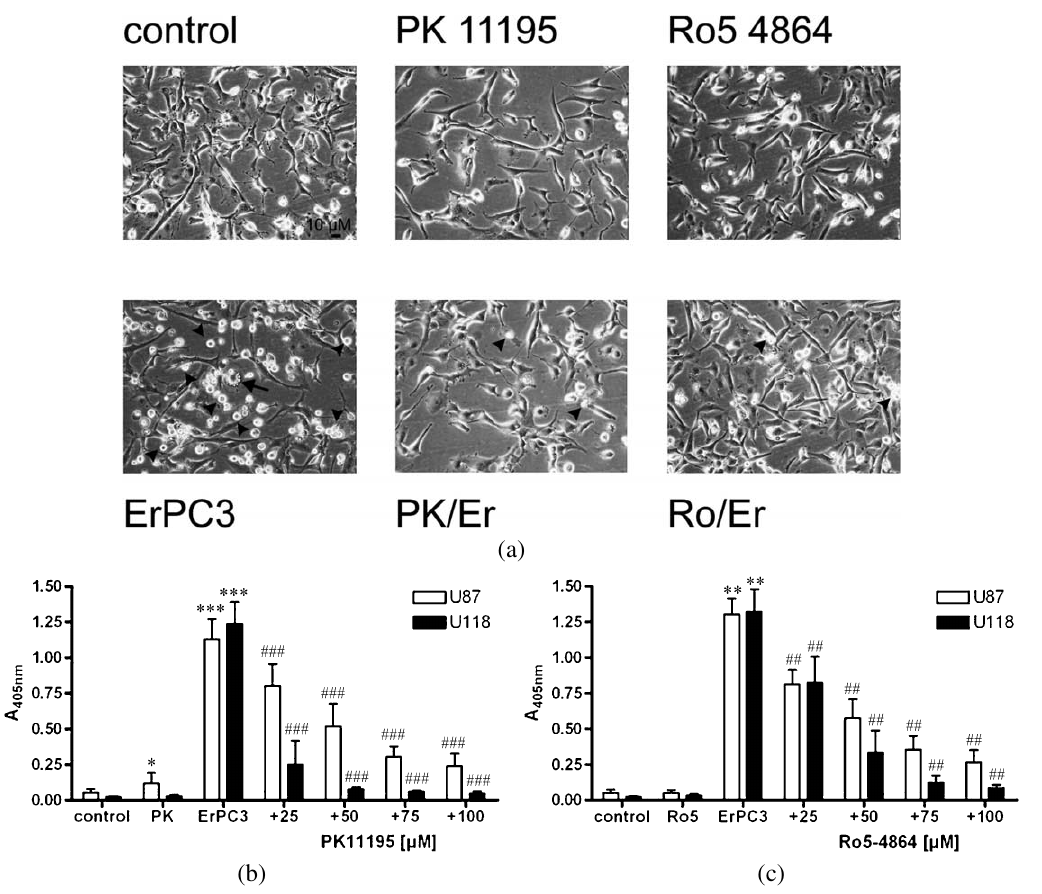
Fig. 5. Cells were treated for 12 hours with various concentrations of PK 11195 or Ro5 4864, with or without ErPC3, and apoptotic morphological changes were determined by phase-contrast microscopy (a) and quantitated by the Cell Death Kit (b, c). (a) In these examples, ErPC3 induced apoptosis in U87MG cells is observable by cell blebbing cell (arrow) and rounded cells (arrow heads). PK 11195 and Ro5 4864 showed no effects by themselves and reduced the effects of ErPC3 (PK/Er and Ro/Er). (b, c) In U87MG and U118MG cells, co-treatment of cells with PK 11195 (b) and Ro5 4864 (c) at concentrations of 25, 50, 75 and 100 µM caused significant reductions of apoptotic levels compared to treatment with ErPC3 alone. Symbols and abbreviations: scale bar is 10 µm (a). + 25, + 50, + 75 and + 100 means co-administration of ErPC3 with, respectively, 25, 50, 75 and 100 µM of PK 11195 (b) or Ro5 4864 (c); ∗ p < 0 . 05 vs. control; ∗∗ p < 0 . 01 vs. control; ∗∗∗ p < 0 . 001 vs. control; ## p < 0 . 01 vs. ErPC3; ### p < 0 . 001 vs. ErPC3; Apoptotic levels are indicated by absorbance of the 405 nm wavelength (A 405 nm